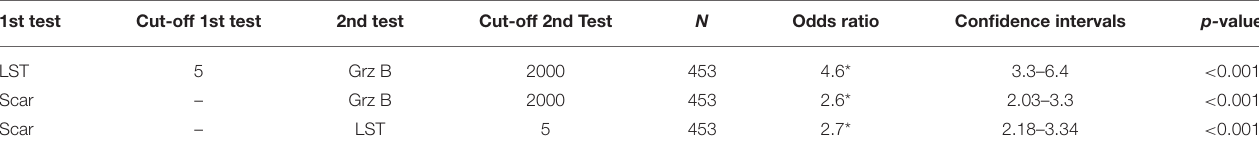
TABLE 3 | Odds ratios and confidence intervals describing the associations between putative markers of previous ZCL and the immune status at baseline for individuals of the study. 1st test Cut-off 1st test 2nd test Cut-off 2nd Test N Odds ratio Confidence intervals p-